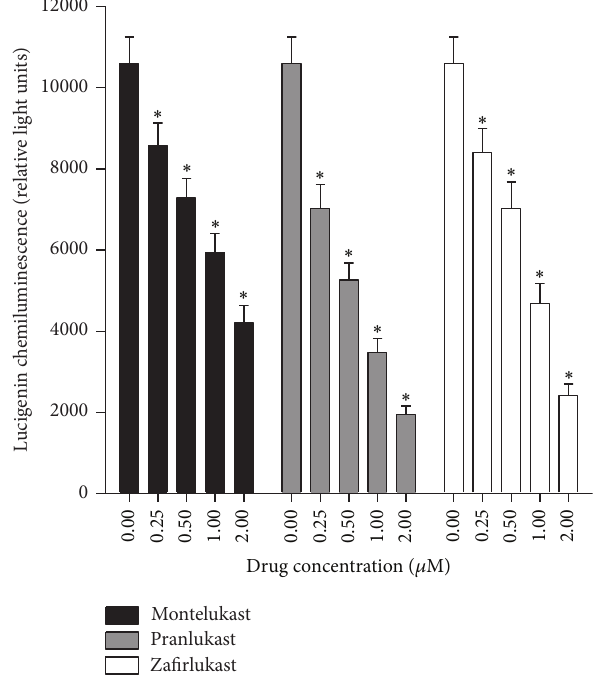
Figure 3: Effects of montelukast, pranlukast, and zafirlukast (0.25– 2 𝜇 M) on the release of elastase from neutrophils activated with N- formyl-L-methionyl-L-leucyl-L-phenylalanine (1 𝜇 M)/cytochalasin B (1 𝜇 M) (fMLP/CB). The results ( 𝑛 = 6 with 5 replicates for each drug concentration and control system in each experiment) are expressed as the mean values for total extracellular elastase (milliunits/10 7 cells) and vertical lines show SEM. The absolute values for the unstimulated control system and for cells activated with fMLP/CB were 33 ± 1 and 937 ± 9 milliunits elastase/10 7 cells. ∗ 𝑃 < 0.05 for comparison with the drug-free control